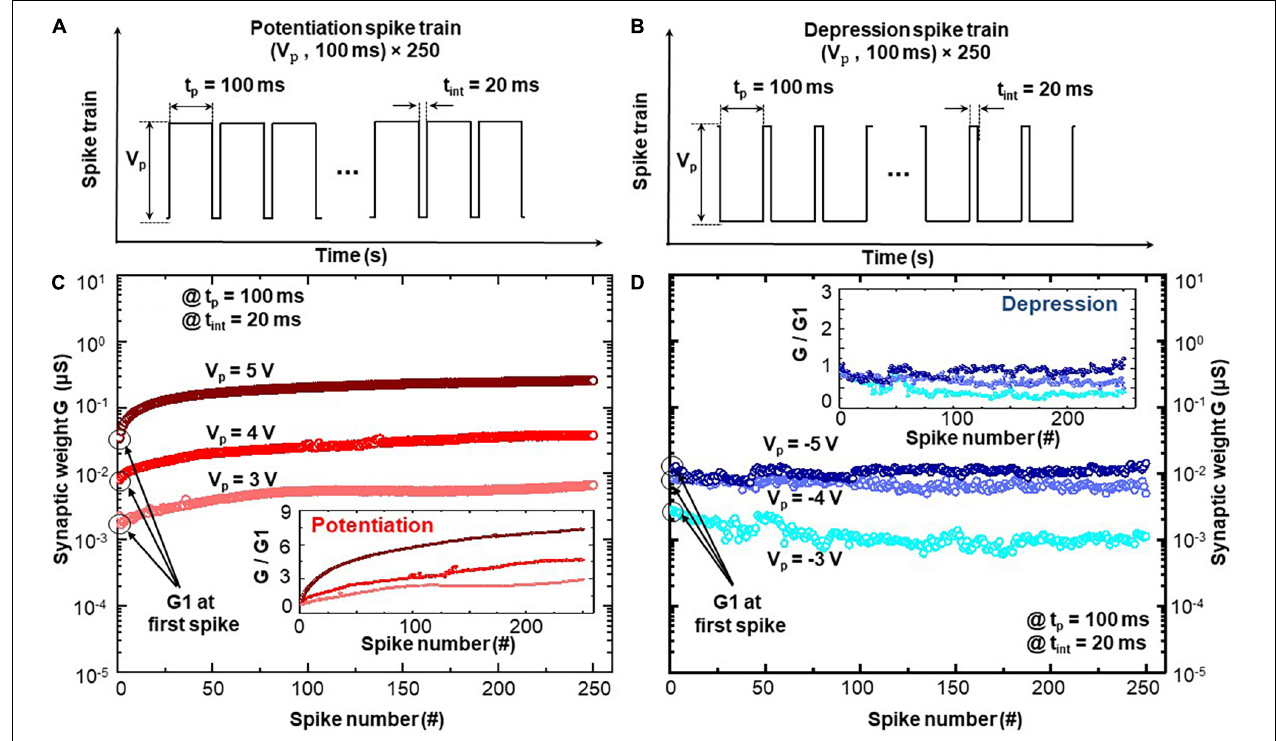
FIGURE 4 | Cycle number-dependent plasticity in BFO artificial synapse: (A) potentiation and (B) depression spike sequence as electrical stimuli applied to BFO artificial synapse with pulse width t p = 100 ms and various pulse amplitudes of V p . The time interval between two pulses is defined as t int = 20 ms. Synaptic weights of panels (C) potentiation and (D) depression dynamics under 250 identical potentiation and depression spikes with pulse amplitudes of V p = 3, 4, and 5 V. Insets in panels (C,D) demonstrate the synaptic change of potentiation and depression dynamics: Synaptic weight G normalized with the synaptic weight G1 recorded at first